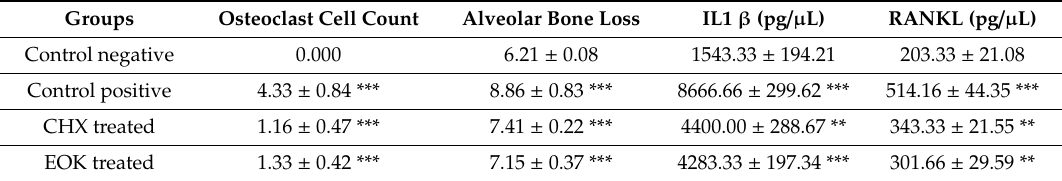
Table 4. Mean values for osteoclast cells, alveolar bone loss, level of IL1 β and RANK expression in each group in the study.